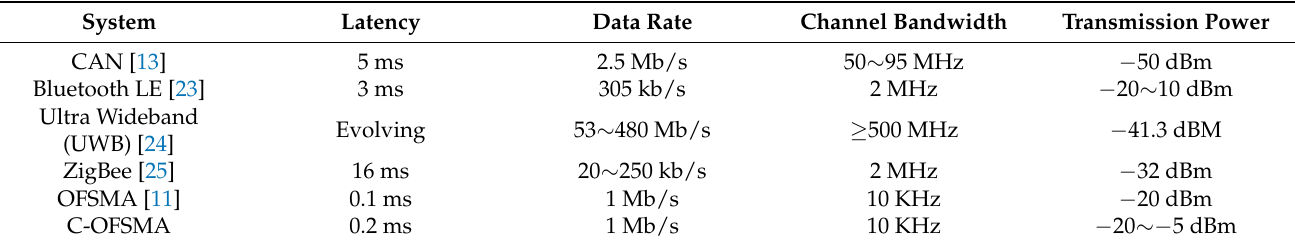
Table 1. Comparison of existing protocols with different